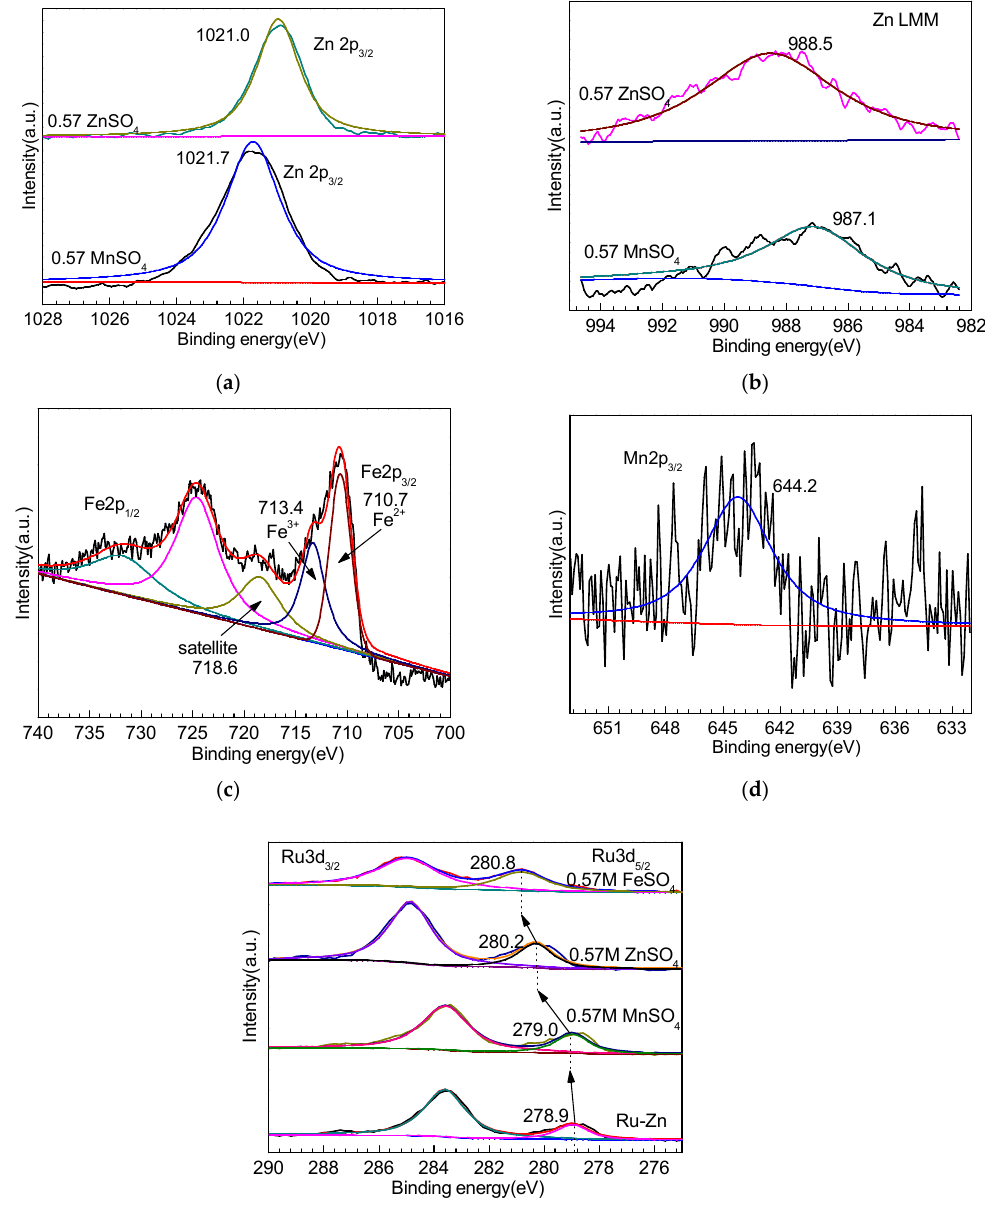
Figure 8. XPS profiles of the Ru ‐ Zn catalyst after hydrogenation reaction applying 0.57 mol L − 1 of ZnSO 4 , FeSO 4, and MnSO 4 as the reaction modifiers. ( a ) Zn 2p 3/2 over the Ru ‐ Zn catalyst applying 0.57 mol L − 1 of ZnSO 4 and MnSO 4 , respectively; ( b ) Zn LMM over the Ru ‐ Zn catalyst applying 0.57 mol L − 1 ZnSO 4 and MnSO 4 , respectively; ( c ) Fe 2p over the Ru ‐ Zn catalyst applying 0.57 mol L − 1 FeSO 4 ; ( d ) Mn 2p 3/2 over the Ru ‐ Zn catalyst applying 0.57 mol L − 1 MnSO 4; and ( e ) Ru 3d 5/2 with and without reaction modifiers.